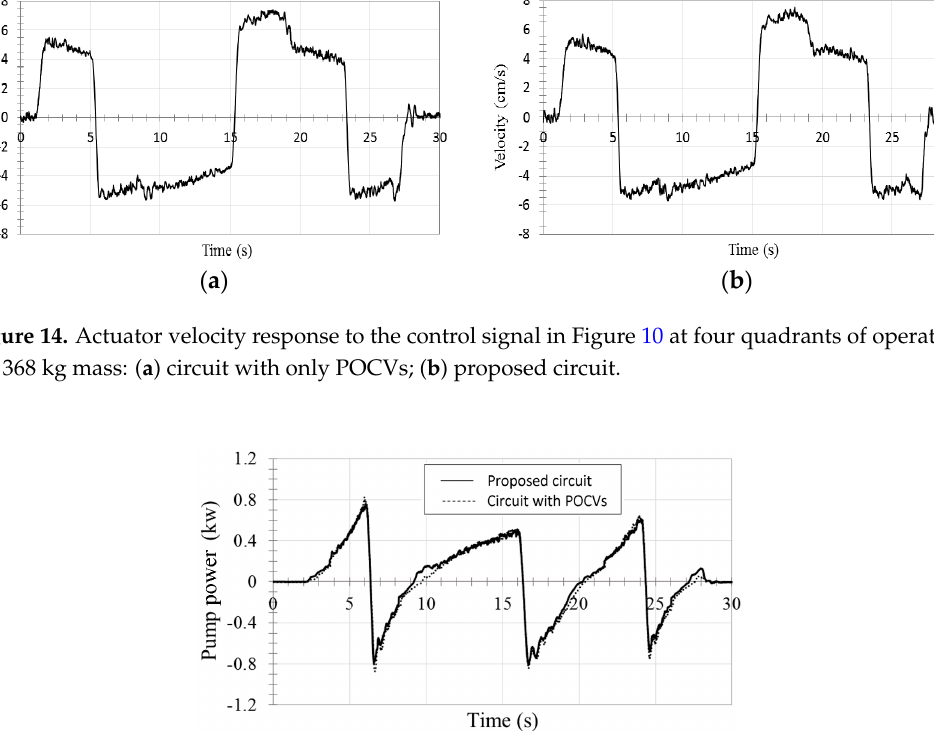
Figure 13. Hydraulic power delivered/received by main pump in circuit utilizes only POCVs and the proposed circuit for control signal in Figure 10 at four quadrants of operation and 41 kg mass.